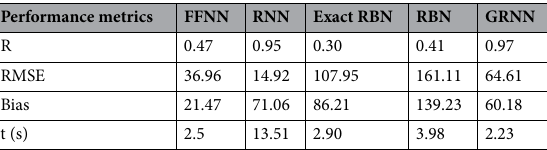
Table 3. Comparing the performance of the AutoML with the deep learning models.